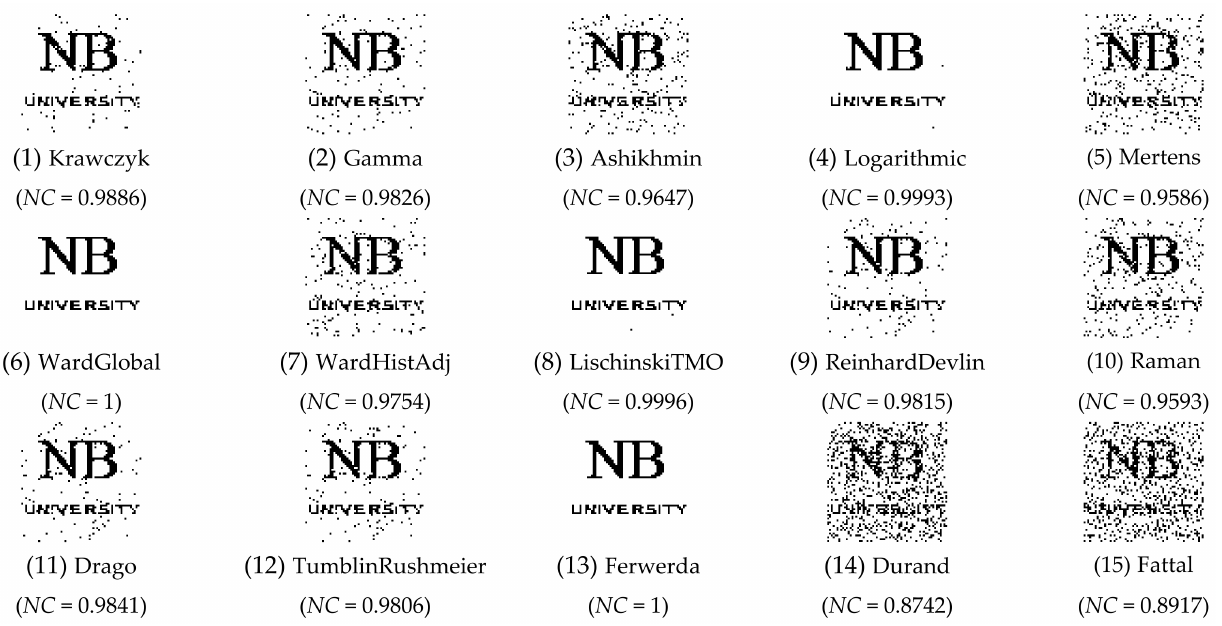
Figure 7. Extracted watermark from Rend01 under different